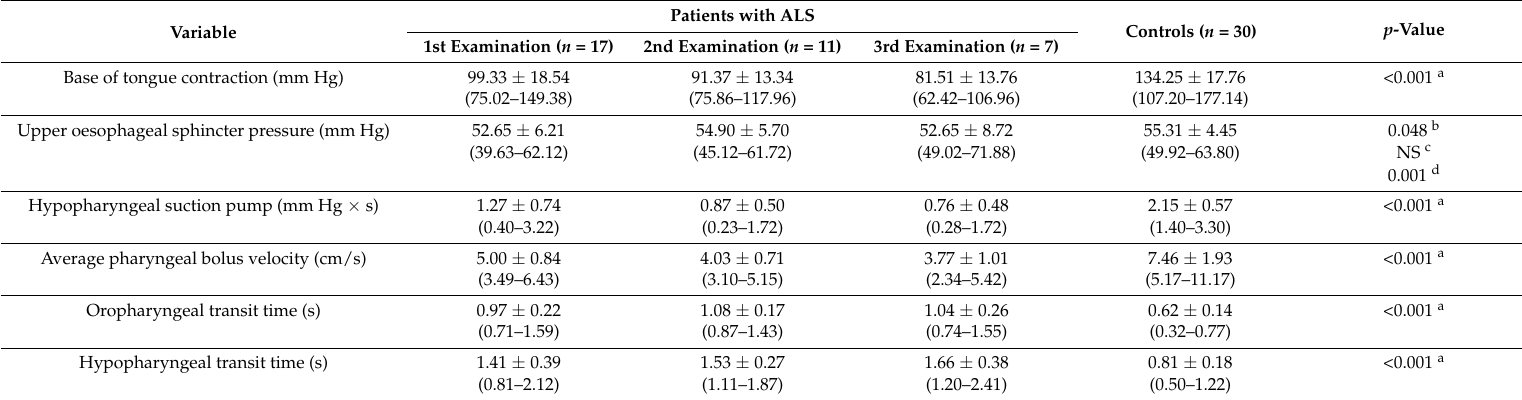
Table 2. Comparison of manometric parameters between patients with amyotrophic lateral sclerosis (ALS) (examinations I–III) and controls during wet swallowing (data are presented as means, standard deviations and